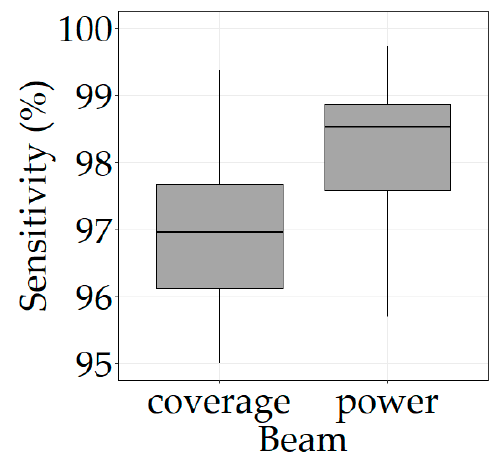
Figure 12. Relation between beam type and beam sensitivity (algorithm setting group number 5). Outliers removed for clarity.